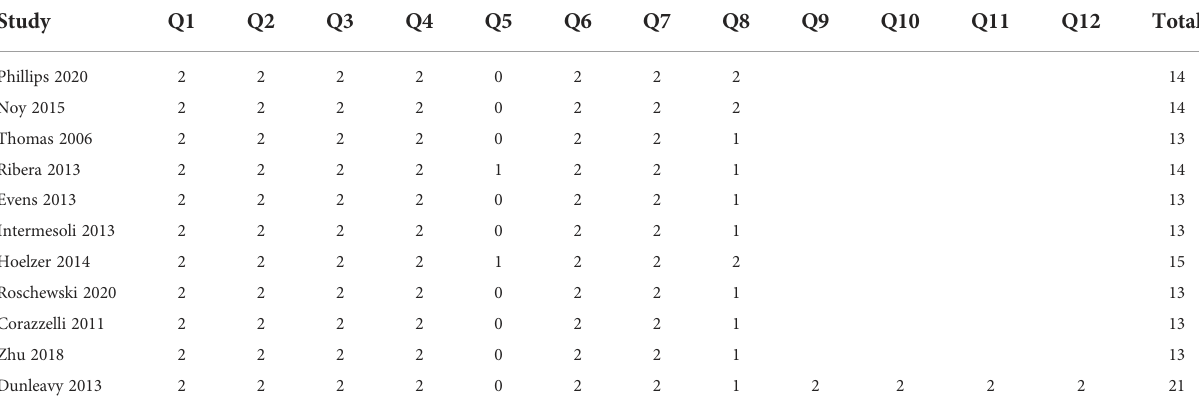
TABLE 2 Quality assessment of included studies.